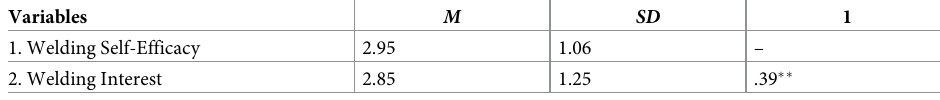
Note . N = 117. M and SD represent mean and standard deviation. � indicates p < .05. �� indicates p < .01.